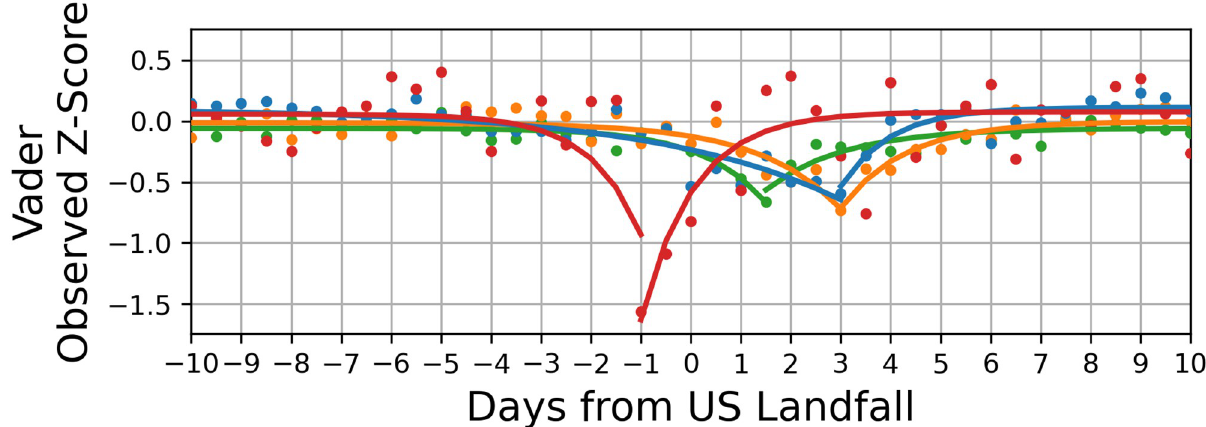
Fig 6. Exponential fits of VADER sentiment and change in sentiment. The first plot shows every 12 hour grouped VADER data. With this, we fit two exponential function to each affected area using. The exponential form is E = ae bt + c where t is the time in days, E is the expected data, and e is the natural